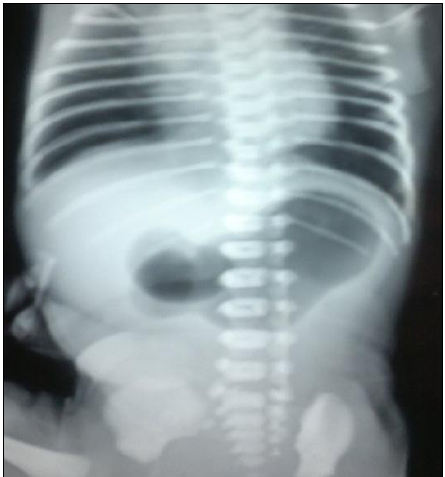
Figure 2: Dilated body and antrum of the stomach with no gas in the distal bowel